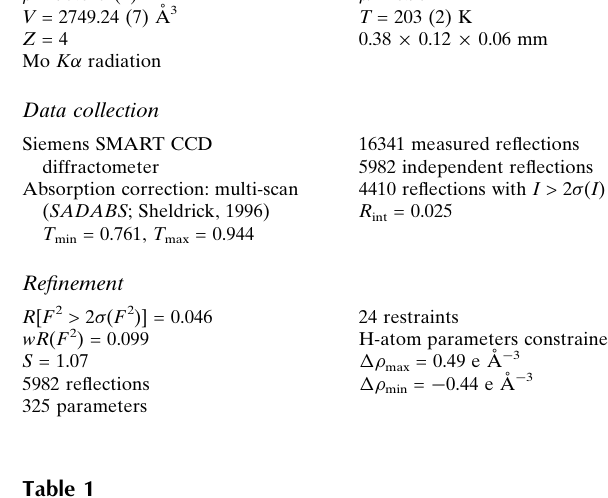
Selected geometric parameters (A˚ , (cid:2)